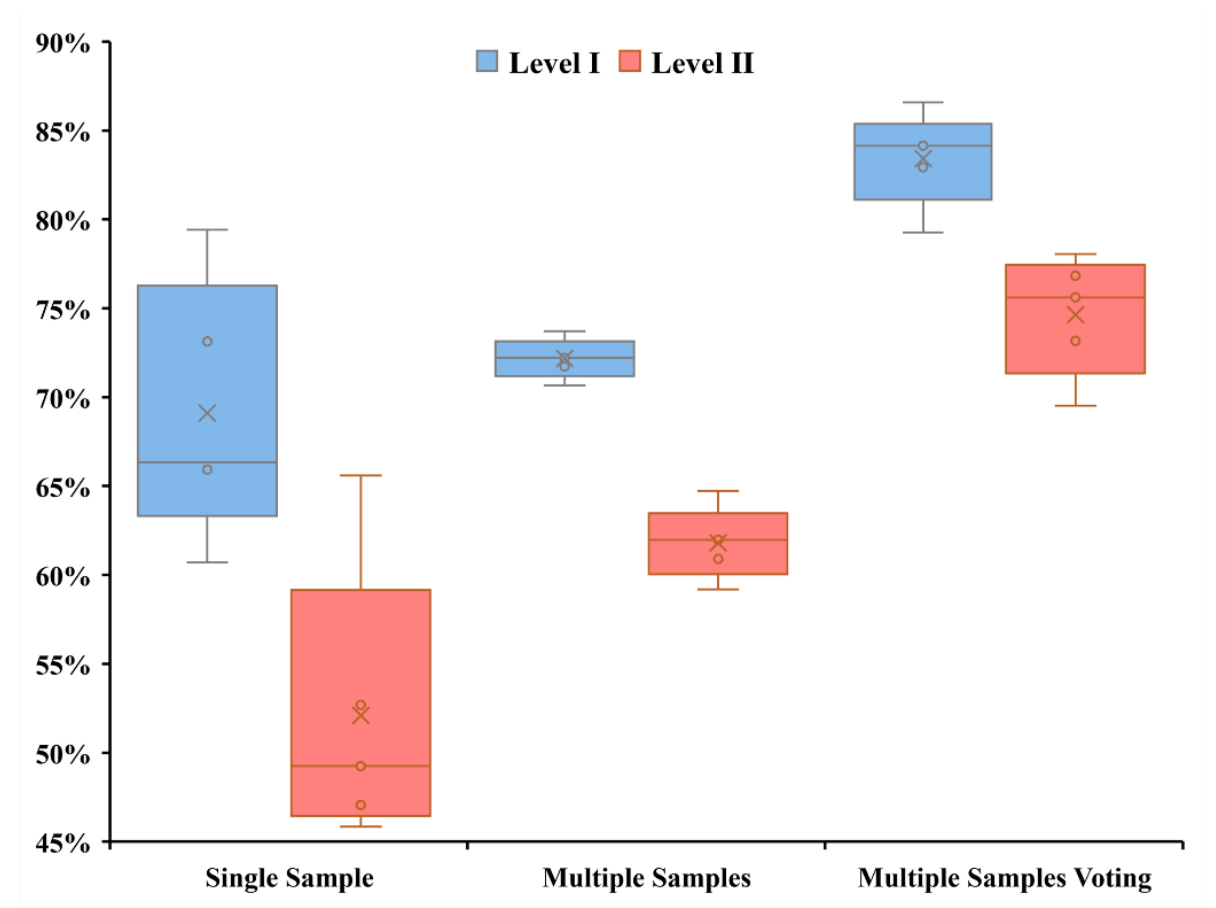
Figure 7. Accuracy distribution of different sample selection strategies. Table 8. Classification accuracy of Level I and Level II land-use